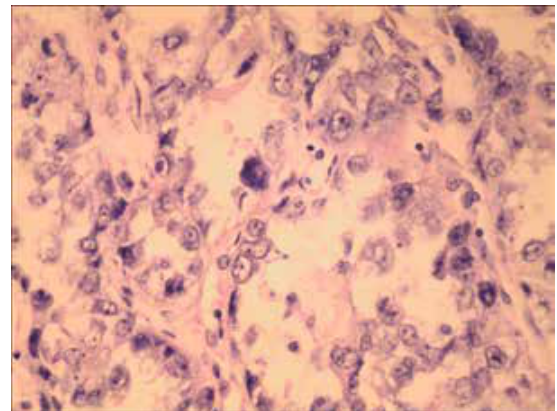
Figure 2 In the same case, the pathological diagnosis revealed an endodermal sinus tumor. This microscopic image is presented at 400× magnification.